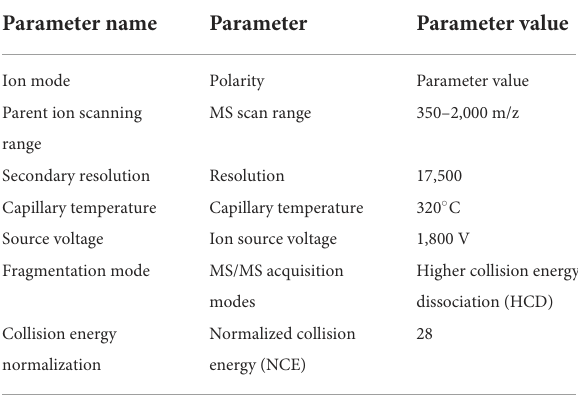
TABLE 1 The parameter of mass spectrometer.